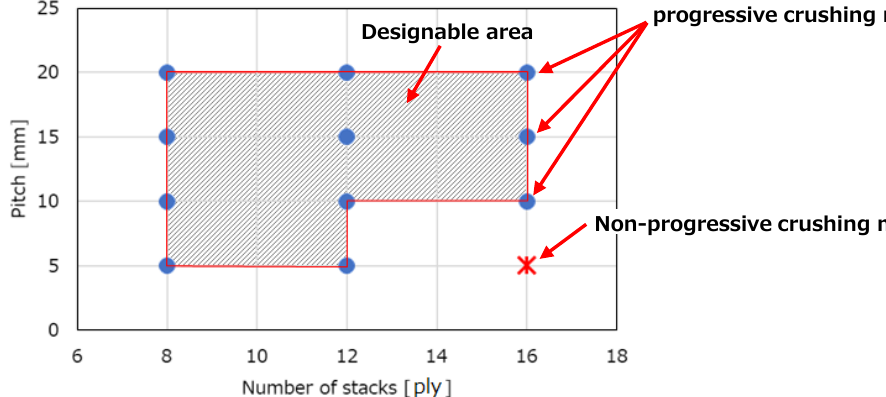
Figure 19. Designable area of corrugate structure.